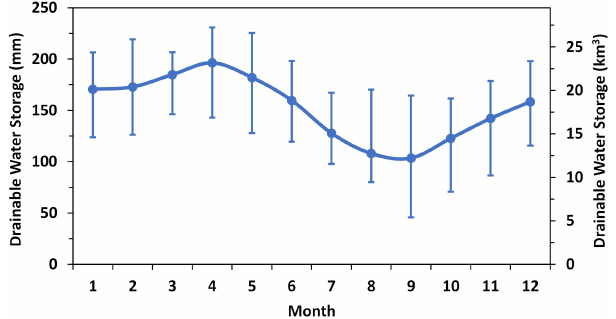
Figure 7. Drainable water storage (DWS) estimated for the Albany River watershed. The blue line represents the mean values, and the vertical bars represent the range of variations for the 15 years of